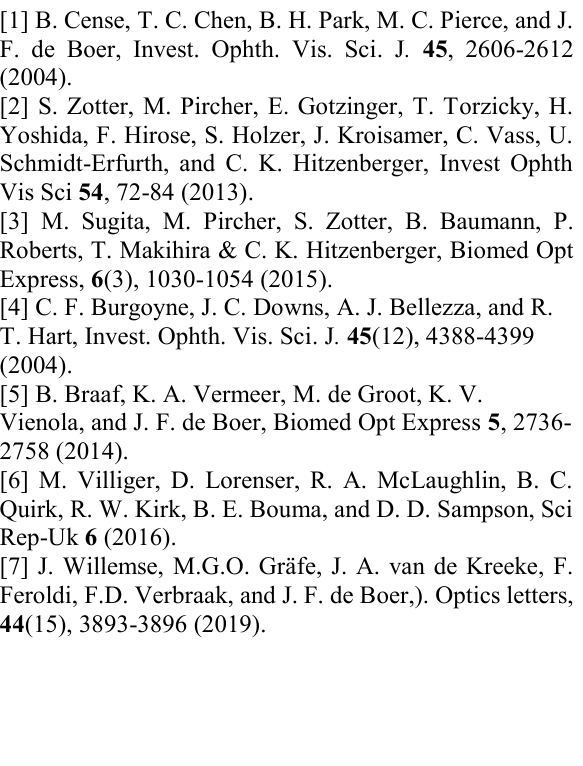
Fig. 2. Sclera orientation images of a healthy volunteer (a) Intensity en face image, (b) sclera orientation en face image, (c-e) cross sections of frames indicated with white in the en face images. Intensity is overlaid with the orientation of pixels with high OAxU. Color range in (b) indicates 0 – 180°. Images sizes: (a - b) 5.7 x 6.2 mm (depth x height), (c- e) 1.2 x 6.2 mm (depth x